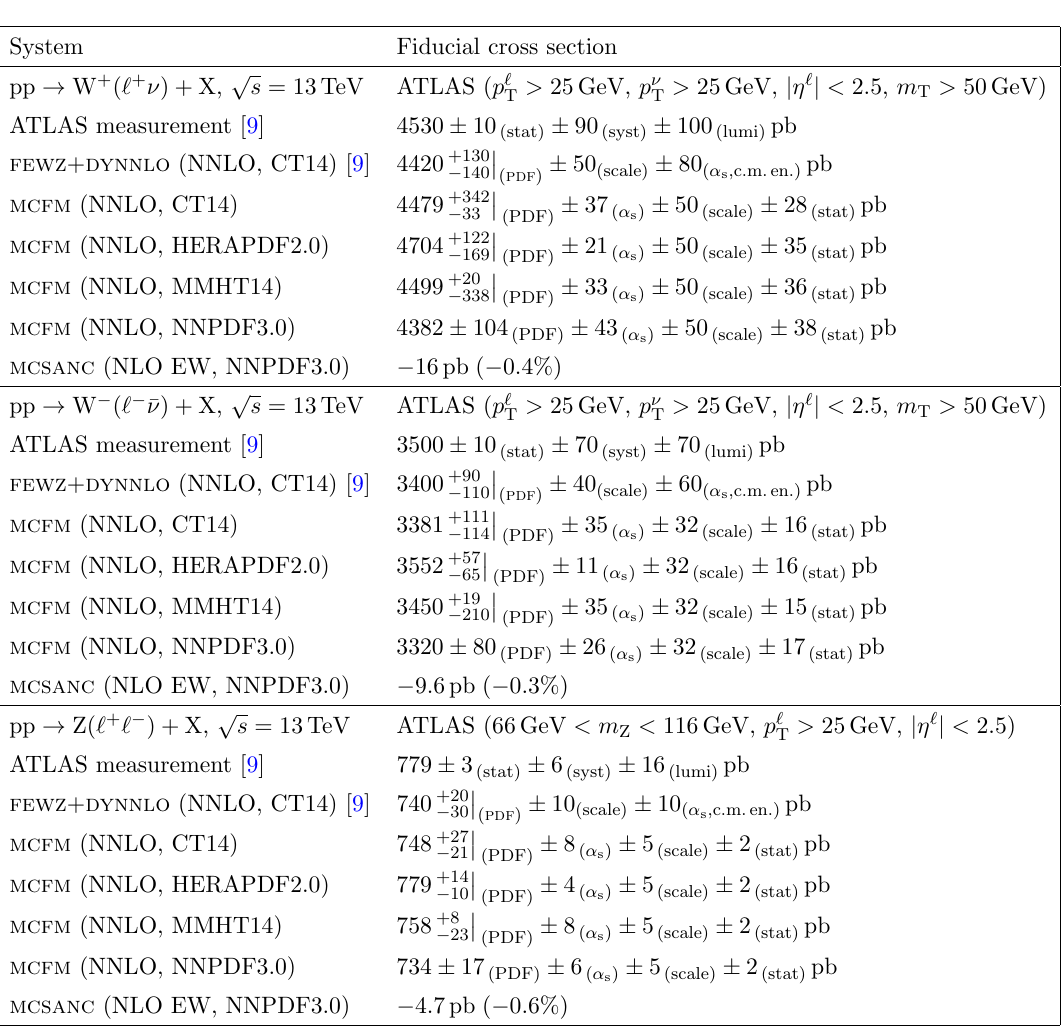
Table 6 . Comparison of the ATLAS (cid:12)ducial cross sections for W + , W (cid:0) , and Z boson production p in pp collisions at s = 13 TeV to the NNLO pQCD results obtained with mcfm using the CT14, HERAPDF2.0, MMHT14, and NNPDF3.0 PDF sets, including NLO EW corrections computed with mcsanc (also listed independently in the last row). Alternative fewz + dynnlo NNLO